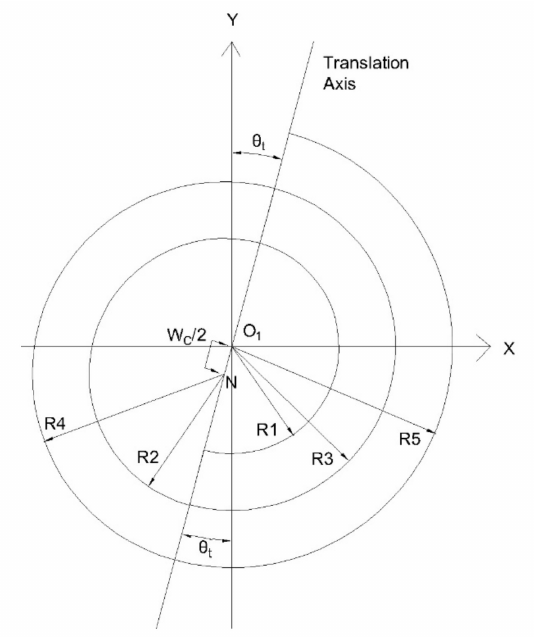
Figure 1. Design of the circulatory roadway.